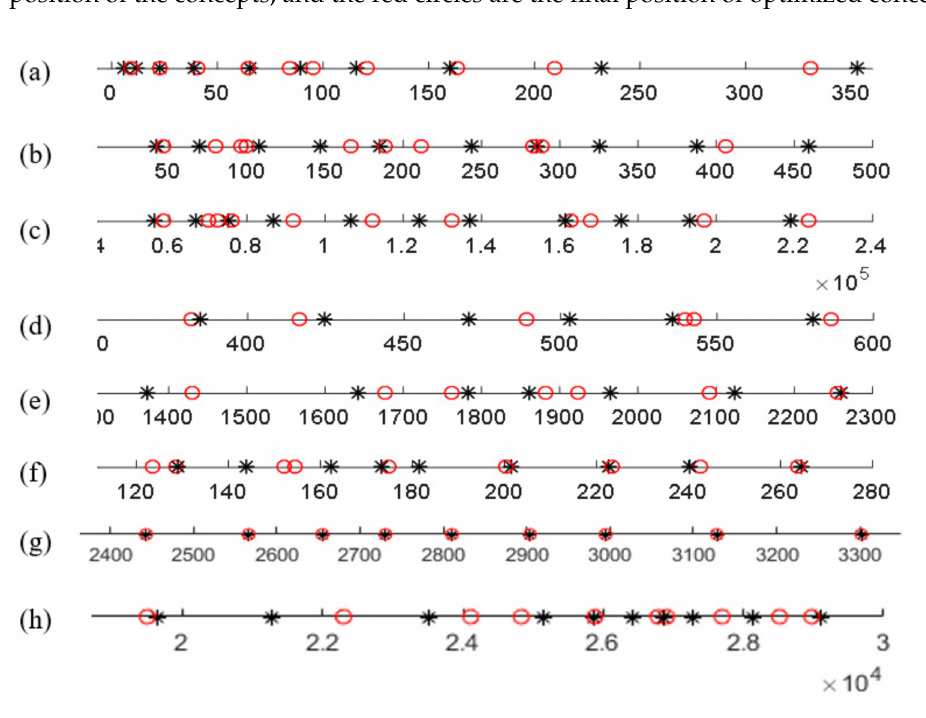
Figure 7. Adjustment concepts. Black star points: the initial position, red circles: the final position. Furthermore, the comparison between the proposed approach and the classical pre- diction approach (Naive, SES, Holt–Winters and ARIMA) is presented in Table 3. As can be noted, the LSFCM approach outperformed the classical prediction models and the LSFCM has the minimum RMSE compared with the other prediction methods. Table 3. Comparison with the classic prediction